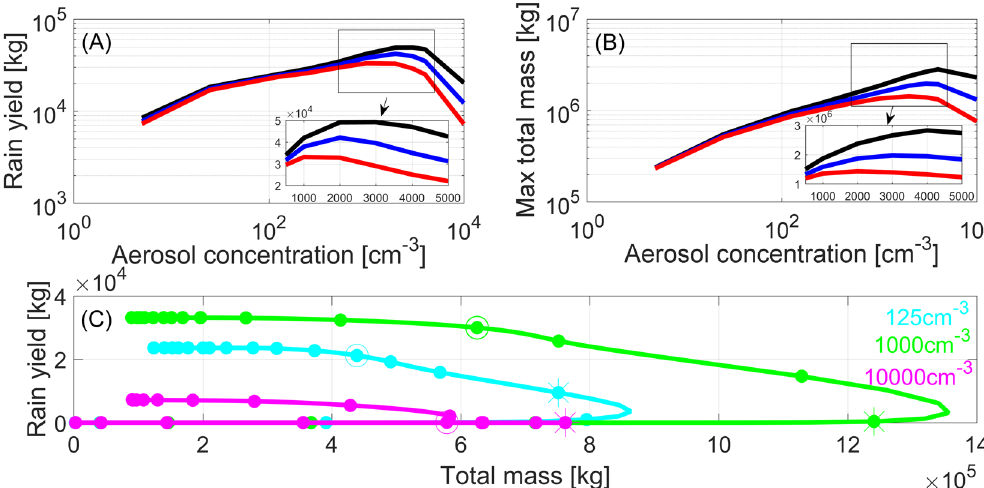
Figure 4. Numerical cloud simulation results. ( A ) Total surface rain yield per simulated cloud and ( B ) cloud’s maximum total mass as a function of aerosol concentration used in the simulation. Note that each curve represents 10 simulations conducted using the same atmospheric profile; the red, blue, and black lines represent a gradually more humid environment (RH 500 of 50.8, 63.3, and 75.8%, respectively; see Fig. S4 for the initialization profiles). The insets show a zoomed-in view of the boxed parts of the curves. ( C ) Temporal evolution of the total cloud mass versus rain yield for three clouds formed under the driest conditions (RH 500 = 50.8%, red profile in Fig. S4) with different aerosol concentrations (125, 1000, and 10,000 cm − 3 ). Note that the dots represent 5-min intervals, and the stars and circles represent simulation times of 30 and 45 min,